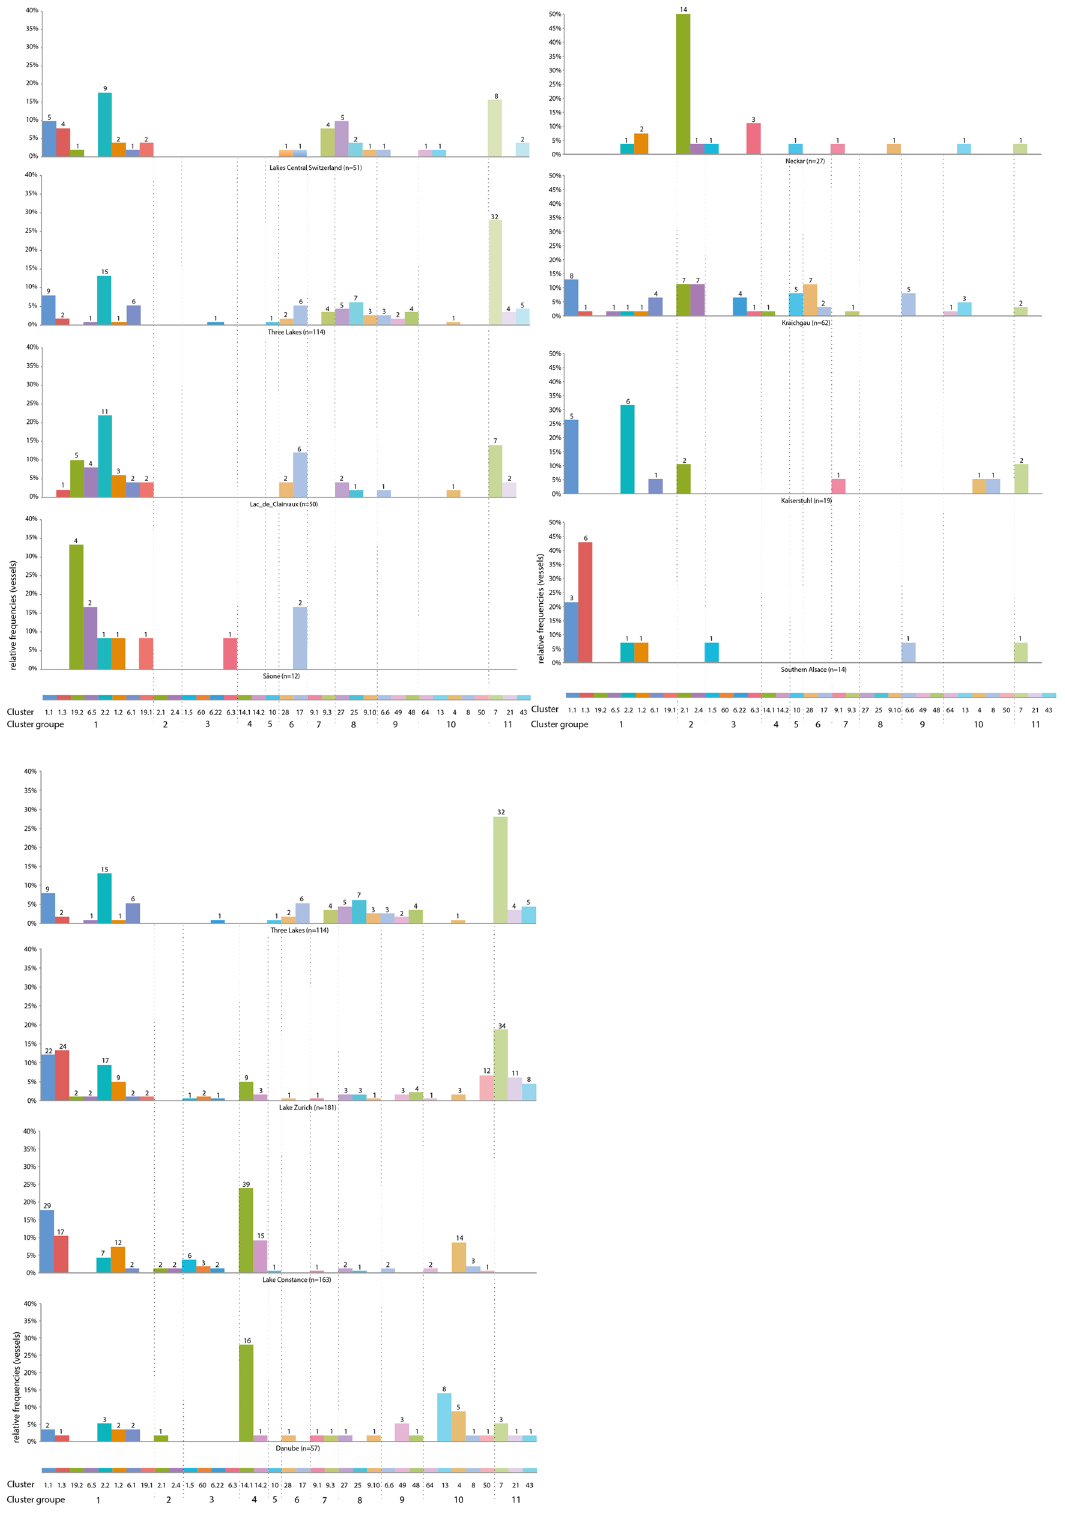
Figure 16: Relative frequencies of represented clusters per region ( fi gure: C. Heitz )